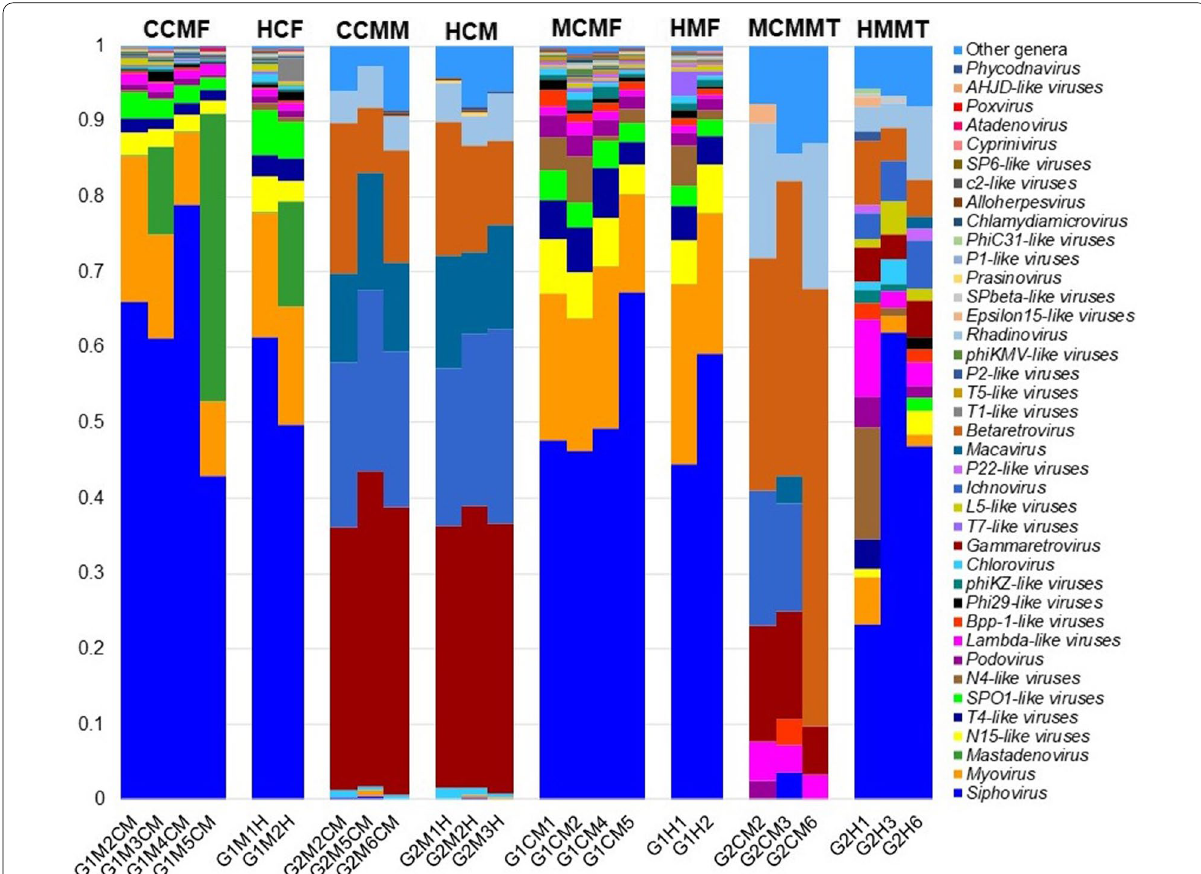
Fig. 7 The genus-level taxonomic profile of viruses identified in cow and mouse mastitis (CCMF, CCMM, MCMF, MCMMT) and healthy (HCF, HCM, HMF, HMMT) samples. Stacked bar plots showing the relative abundance and distribution of the 40 top abundant viral genera, with ranks ordered from bottom to top by their decreasing proportion of relative abundances, with the remaining genera keeping as ‘Other genera’. Each stacked bar plot represents the abundance of viral genera in each sample of the corresponding category. Notable differences in viral populations are those where the taxon is abundant in clinical mastitis (cow and mouse) samples, and effectively undetected in the healthy (cow and mouse) controls. The distribution and relative abundance of the viral genera in the study metagenomes are also available in Additional file